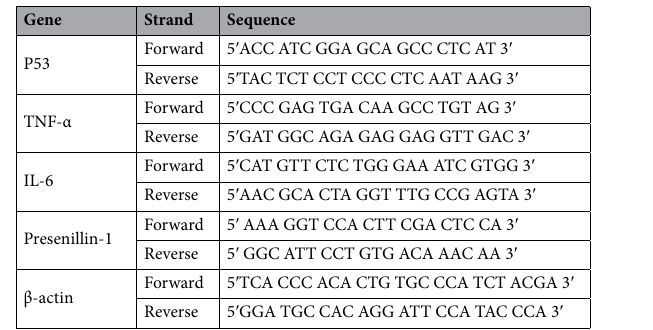
Table 1. Sequences of the used primers in